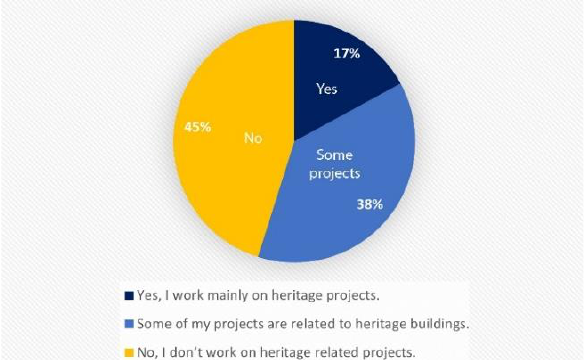
Figure 2: Responses of participants on whether they work in heritage related